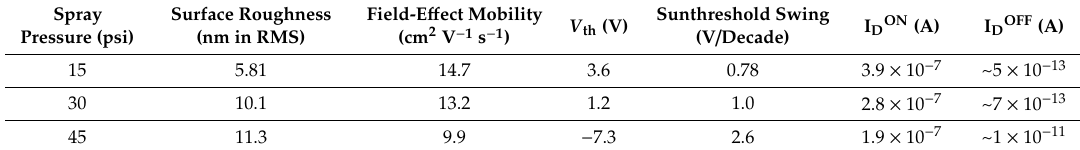
Figure 3. ( a ) Drain and gate current vs. V G characteristics of ZnO FETs, fabricated using various spray pressures (15 psi, 30 psi, 45 psi) in log scale ( V D = 0.1 V). ( b ) Root–mean–square (RMS) roughness of ZnO thin films formed using three different spray pressures: 15 psi, 30 psi, 45 psi. ( c ) Transfer characteristics (log( I D ) – V G ) of the staggered bottom-gate ZnO FETs using spray pyrolysis technique at linear (at V D = 0.1 V) and saturation (at V D = 20 V) regions with the gate leakage ( I G ). ( d ) Output characteristics ( I D – V D ) of the ZnO FETs. Table 2. The morphological and electrical characteristics of ZnO FETs formed at various spray pressures of 15 psi, 30 psi, and 45 psi.